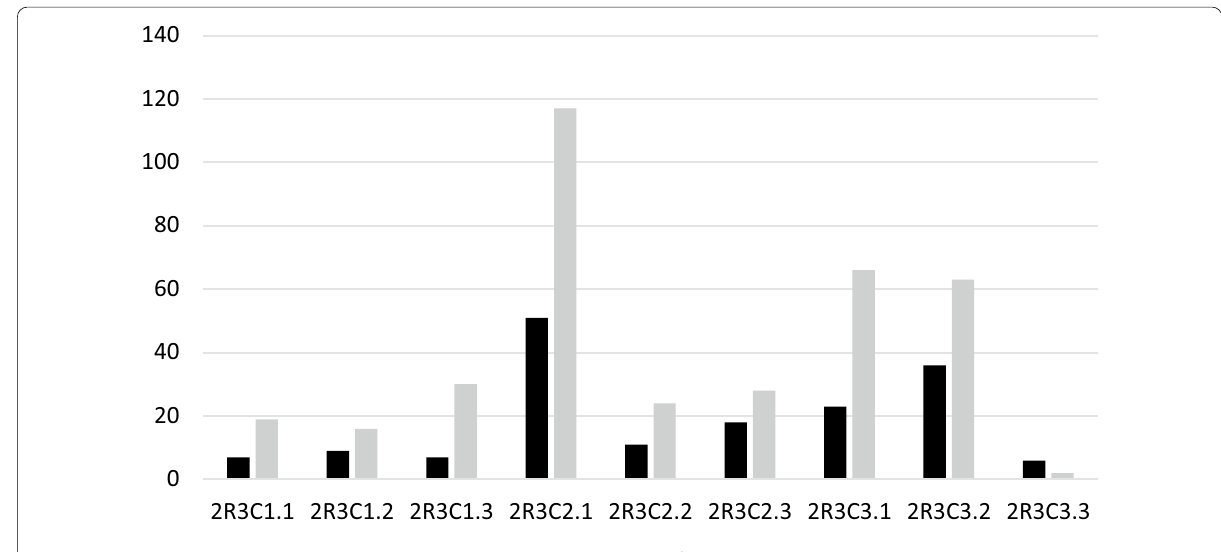
Fig. 8 Distribution of articular patterns of DRFs according to gender. M, male; F, female; DRFs, distal radius